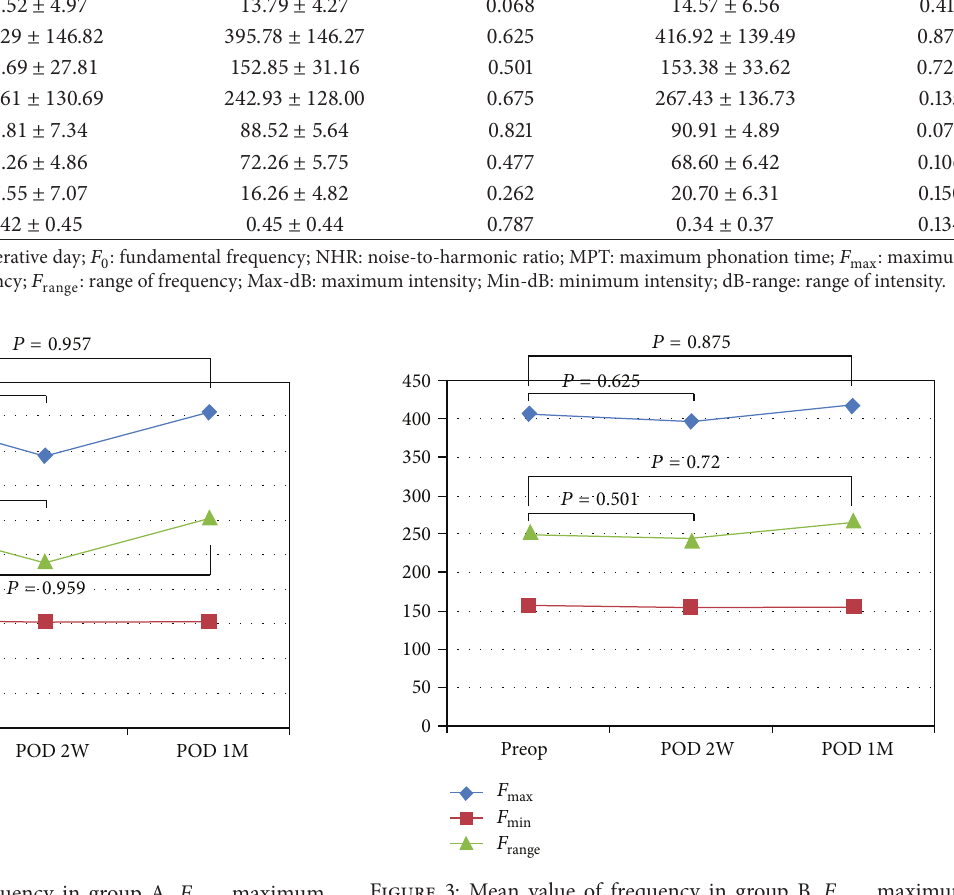
Figure 2: Mean value of frequency in group A. 𝐹 max , maximum frequency; 𝐹 min , minimum frequency; 𝐹 Preop, preoperative; POD, postoperative day; 2W, 2 weeks; and 1M, 1 month.